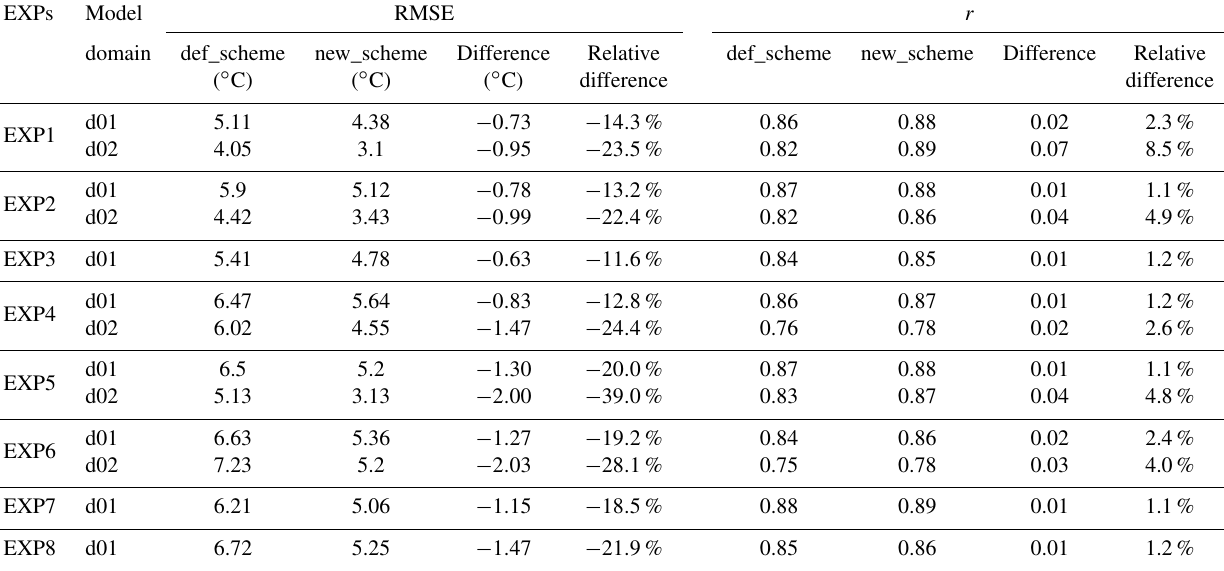
Table 3. RMSE and correlation coefficient ( r ) for air temperature between CMA observations and model estimates, calculated using the default Noah snow albedo scheme (def_scheme) and the improved albedo scheme (new_scheme). The difference in RMSE is new_scheme RMSE minus def_scheme RMSE. The difference in r is new_scheme r minus def_scheme r . P value < 0.05 is the significance test for the correlation.